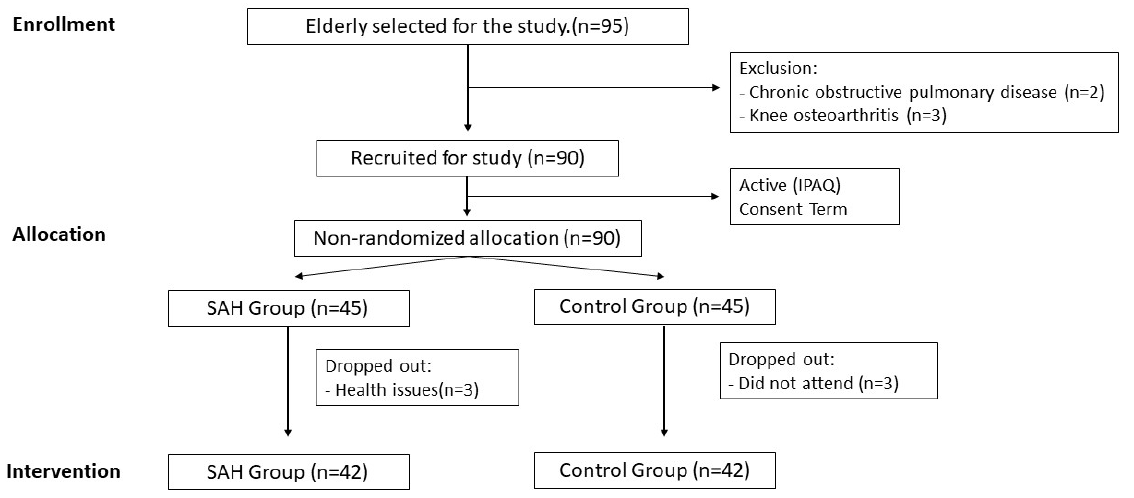
Figure 1. Flow chart of the study